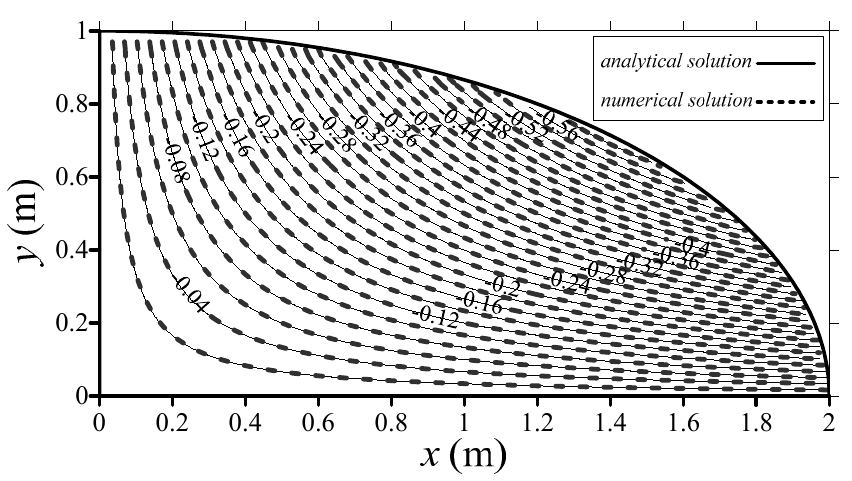
Figure 6. Comparison of the temperature distribution with the analytical solution.